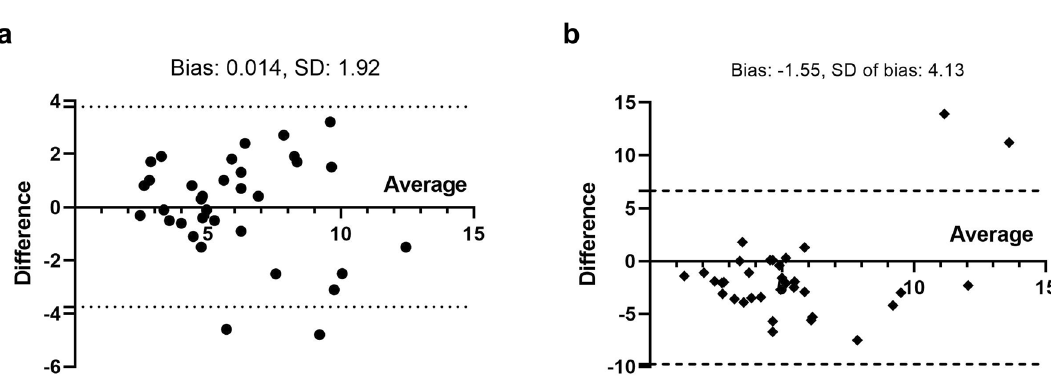
Figure 3. Bland–Altman plots for agreement of TNr between SPECT/CT and PET/CT ( a ); between planar image and PET/CT ( b ).